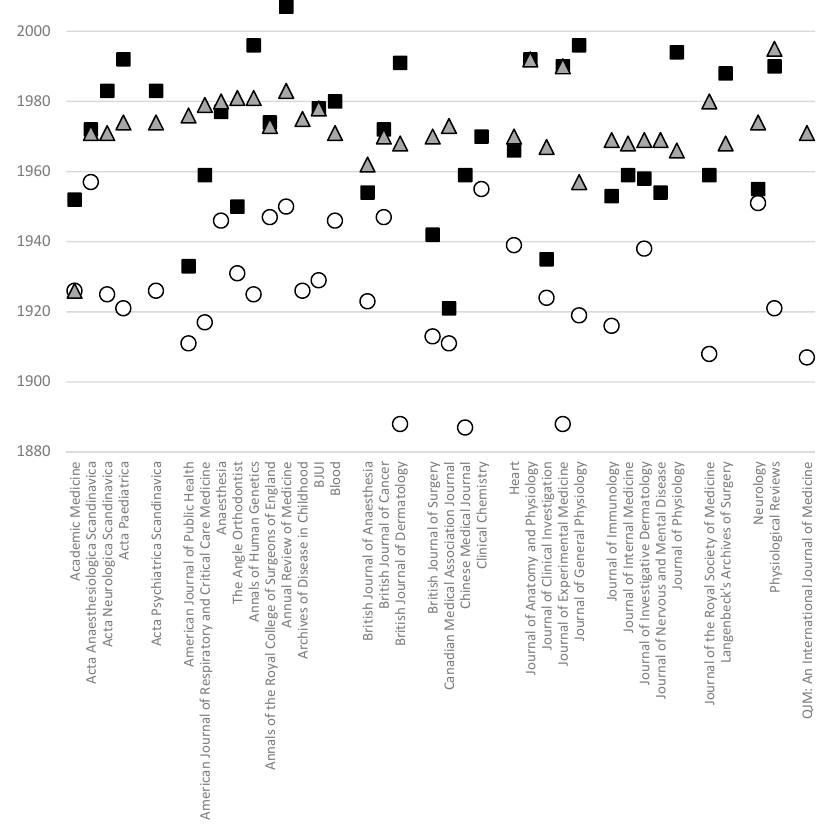
Figure 2. This graph summarizes the introduction of a two-column layout and abstract in the printed edition for each of the journals that were considered in the present commentary. White circles indicate the date the journal was first published, black squares—the year they switched to a two-column format, and the grey triangles—the year abstracts at the beginning of articles were introduced. The figure does not include the introduction of digital